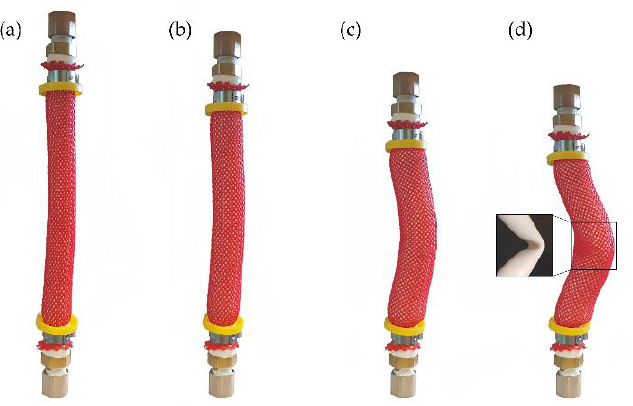
Figure 2. The progression of a fluidic artificial muscle (FAM) contracting from its free length ( a ), up to free strain ( b ), and into the resistive force regime. In the post-buckling region ( c ), the bladder is deformed into the first mode shape of a clamped-clamped column. The bladder enters the post- collapse region ( d ) as the bladder cross-section deforms from its initial circular shape.